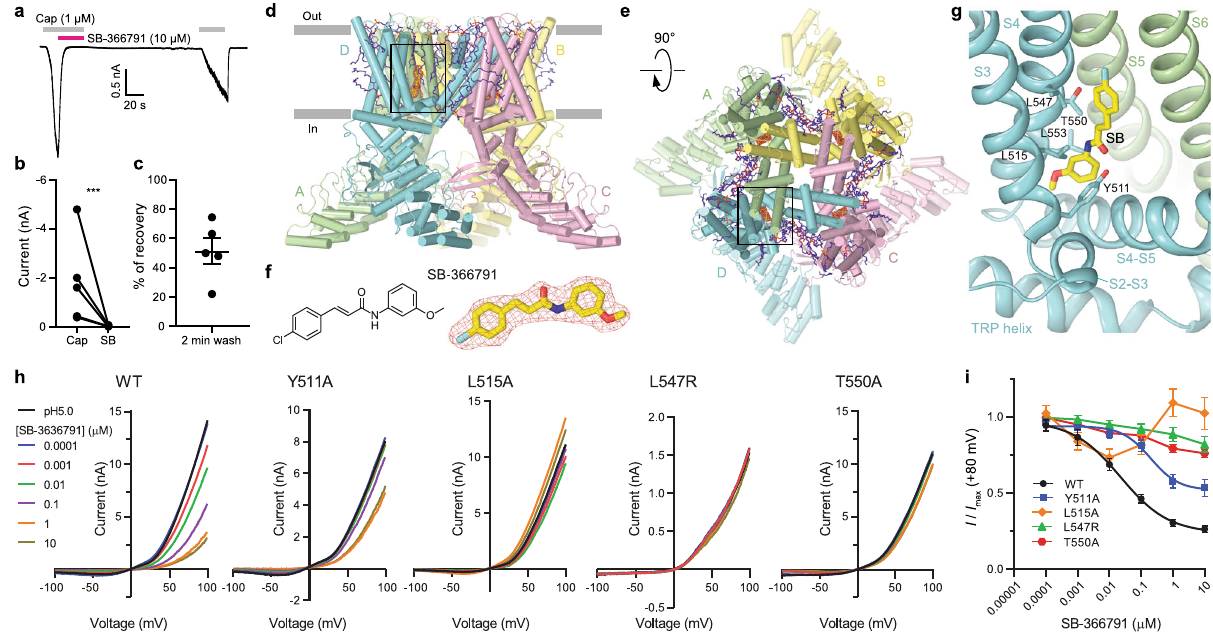
Fig. 2 | Structure of human TRPV1 in complex with the inhibitor SB-366791. a Exemplar whole-cell current recorded at – 40mV from HEK 293 cell expressing hTRPV1 in response to application of 1 µ M of capsaicin (Cap) and 10 µ M of SB- 366791. b Quanti fi cation of the inhibitory effect of 10 µ M SB-366791 on hTRPV1 peak current amplitude in the presence of 1 µ M capsaicin, measured 10s after SB- 366791 application. Statistical analysis: two-tailed paired t -test. *** P =0.0003. Data points represent paired recordings from 5 individual cells. c Quanti fi cation of capsaicin-stimulated hTRPV1peakcurrent amplitude recoveryaftertermination of SB-366791 application. The cell was washed for at least 2min before the second application of Cap. Data are shown as mean±SEM. Data points represent record- ings from 5 individual cells. d , e hTRPV1 SB-366791 structure viewed parallel to the membrane ( d ) or extracellularly ( e ),with subunits colored green, yellow, pink,and